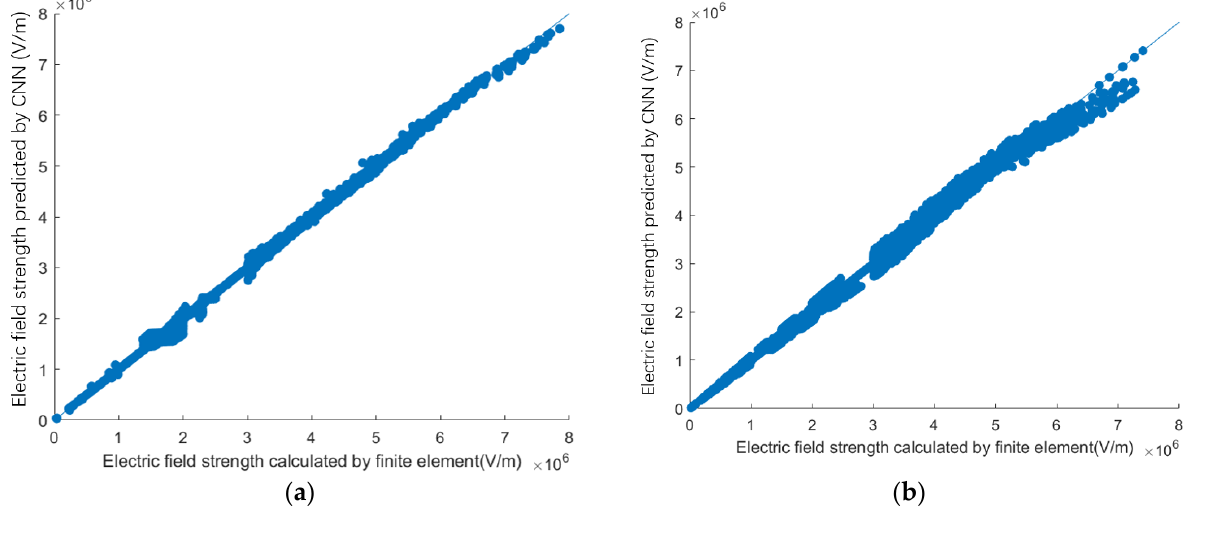
Figure 3. Training results of the convolutional neural network algorithm on the training and test sets, ( a ) Fitting results of single impurity in cable, ( b ) Fitting results of multiple impurities in cable.